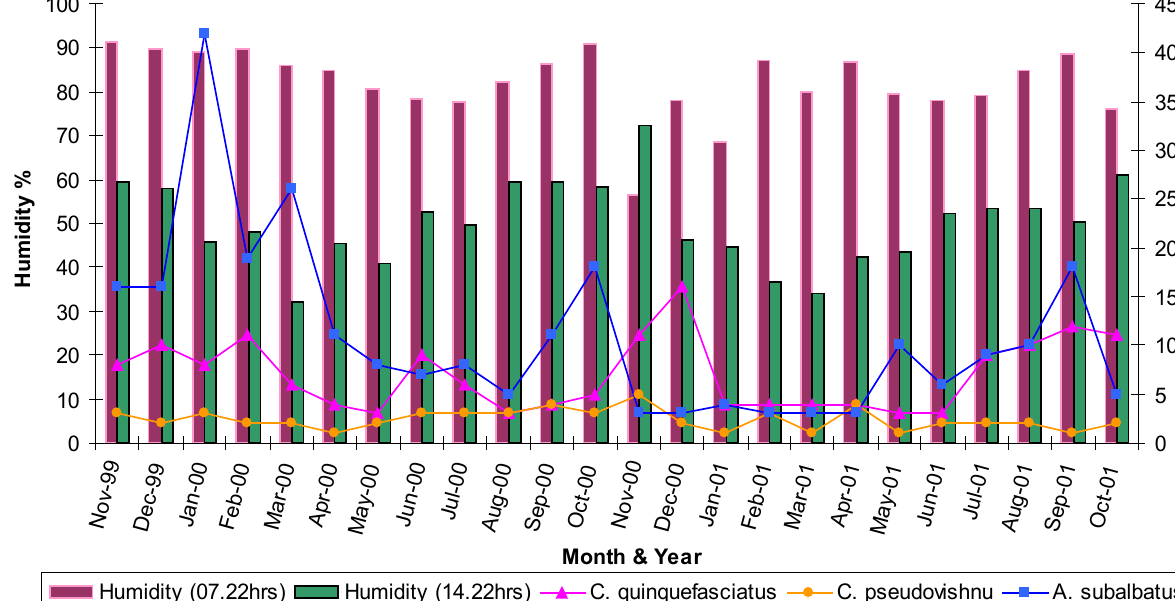
Figure 5. Population dynamics of mosquito species in relation to humidity (0722 & 1422 hr) in Gandhipuram